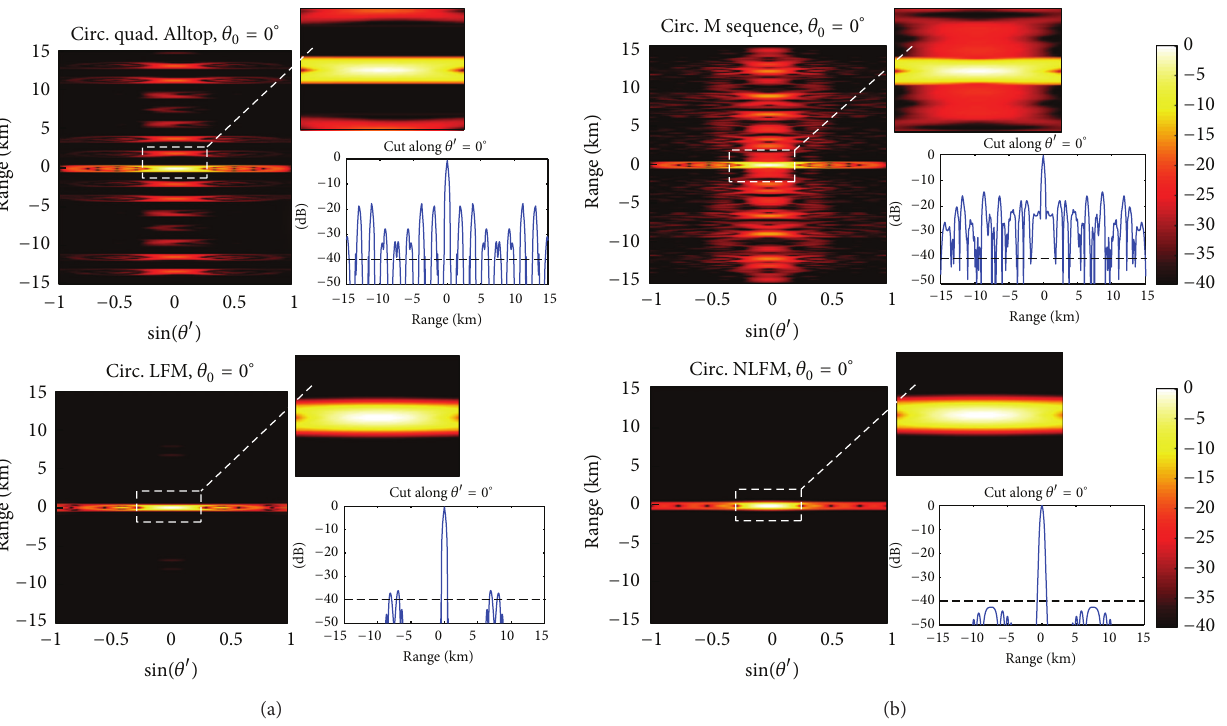
(𝜏 󸀠 ,𝜃 󸀠 )| 2 at 𝜃 = 0 ∘ in 0 0